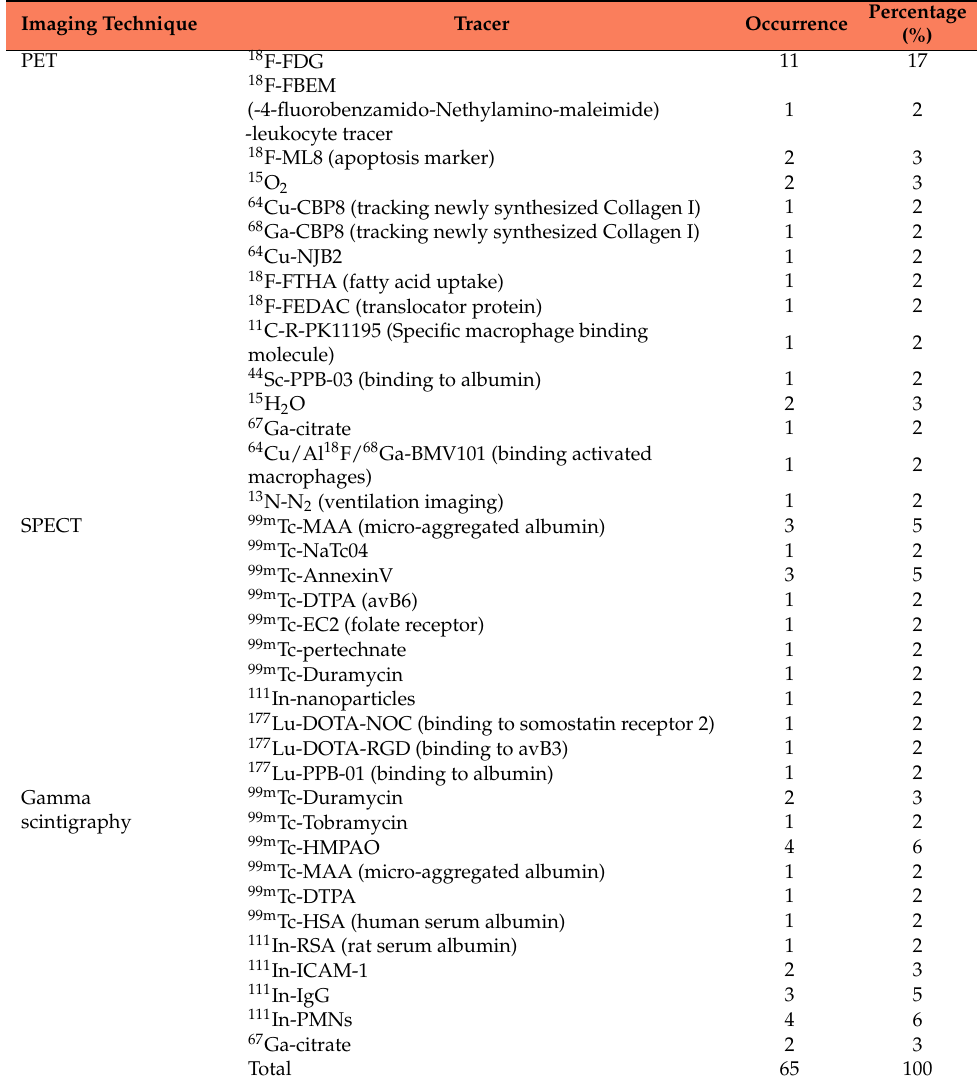
Table 5. Tracers summarized in one table, separated by the imaging techniques where they were